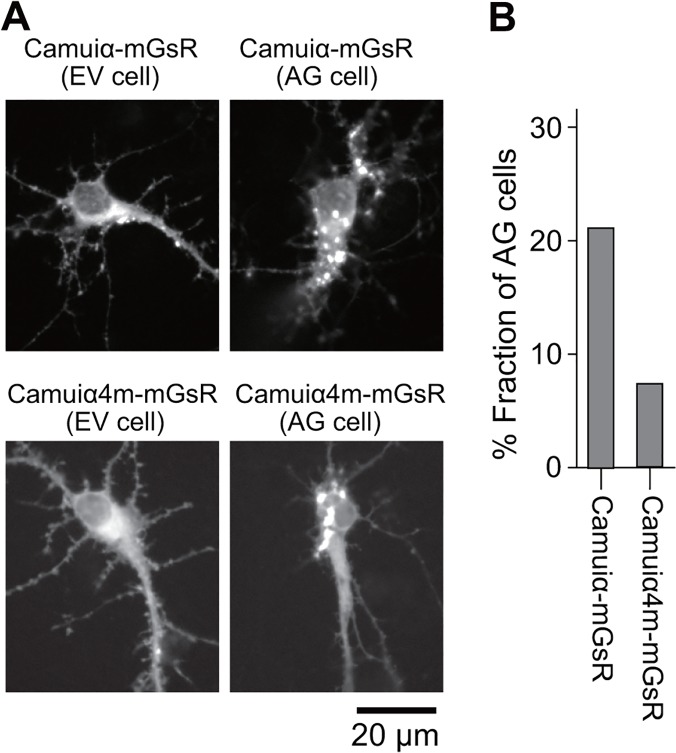
Expression patterns of the Camuiα-mGsR mutants in dissociated hippocampal neurons.
(A) Hippocampal neurons were cultured, transfected, and imaged as described in the Methods. Neurons exhibited evenly distributed (left, EV cell) and aggregated (right, AG cell) Camuiα-mGsR (Top) and Camuiα4m-mGsR (Bottom). Scale bar = 20 μm. (B) The number of neurons with aggregated Camuiα in soma were counted for the Camuiα mutants (Camuiα, 21.3% (23/108 cells); Camuiα4m, 7.4% (8/108 cells)).